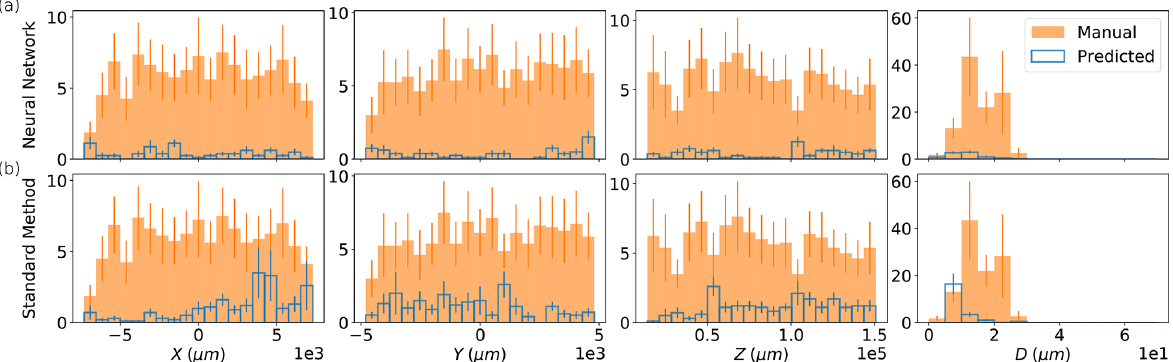
Figure A2. Histograms for x , y , z , and d for false predictions are shown in each column, for the 10 testing HOLODEC holograms. The results for the standard method and the N SH = 1000 model are shown in (a) and (b) , respectively, relative to the true histograms. The value of each bin and the error bar were computed by taking the mean and standard deviation across the 10 test HOLODEC holograms.